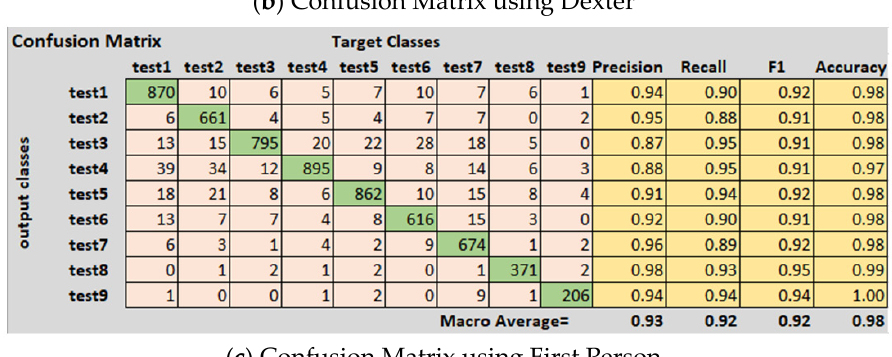
Figure 3. Confusion matrices of the performance results by the proposed model by using ( a ) Kaggle, ( b ) Dexter, and ( c ) First Person datasets. ( b ) Dexter, and ( c ) First Person